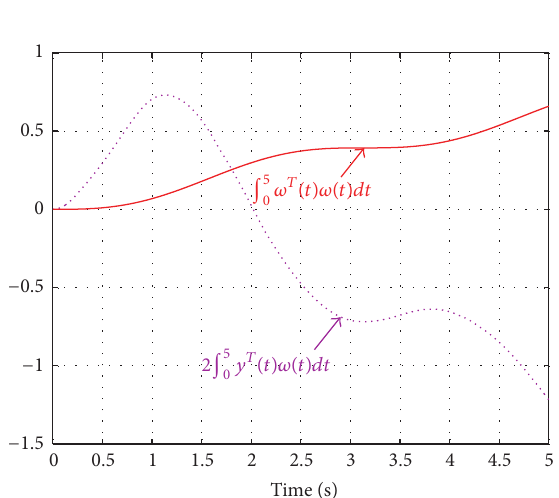
5 𝑦 𝑇 (𝑡)𝜔(𝑡)𝑑𝑡 and ∫ 5 0